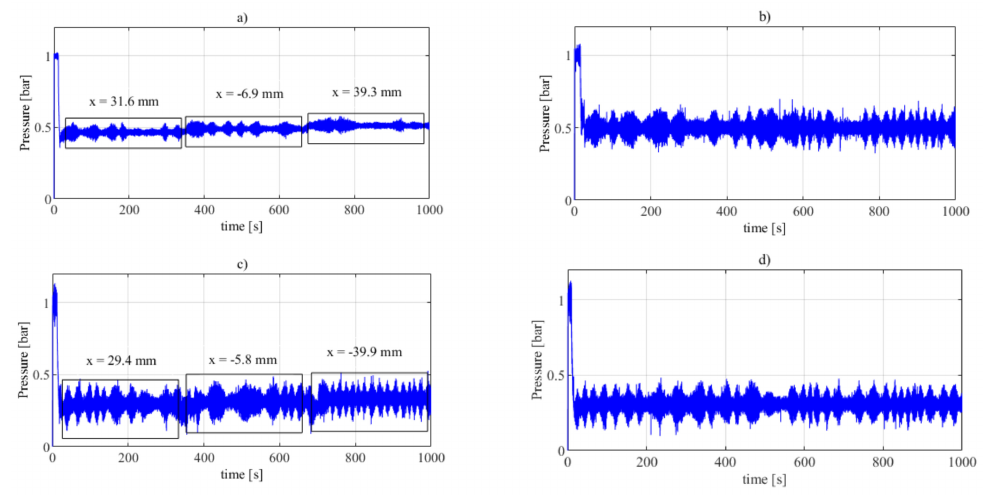
Figure 15. Vacuum measurements inside the BCM hull: ( a ) test 1 @0.5 bar; ( b ) test 2 @0.5 bar; ( c ) test 1 @0.3 bar; ( d ) test 2 @0.3 bar.